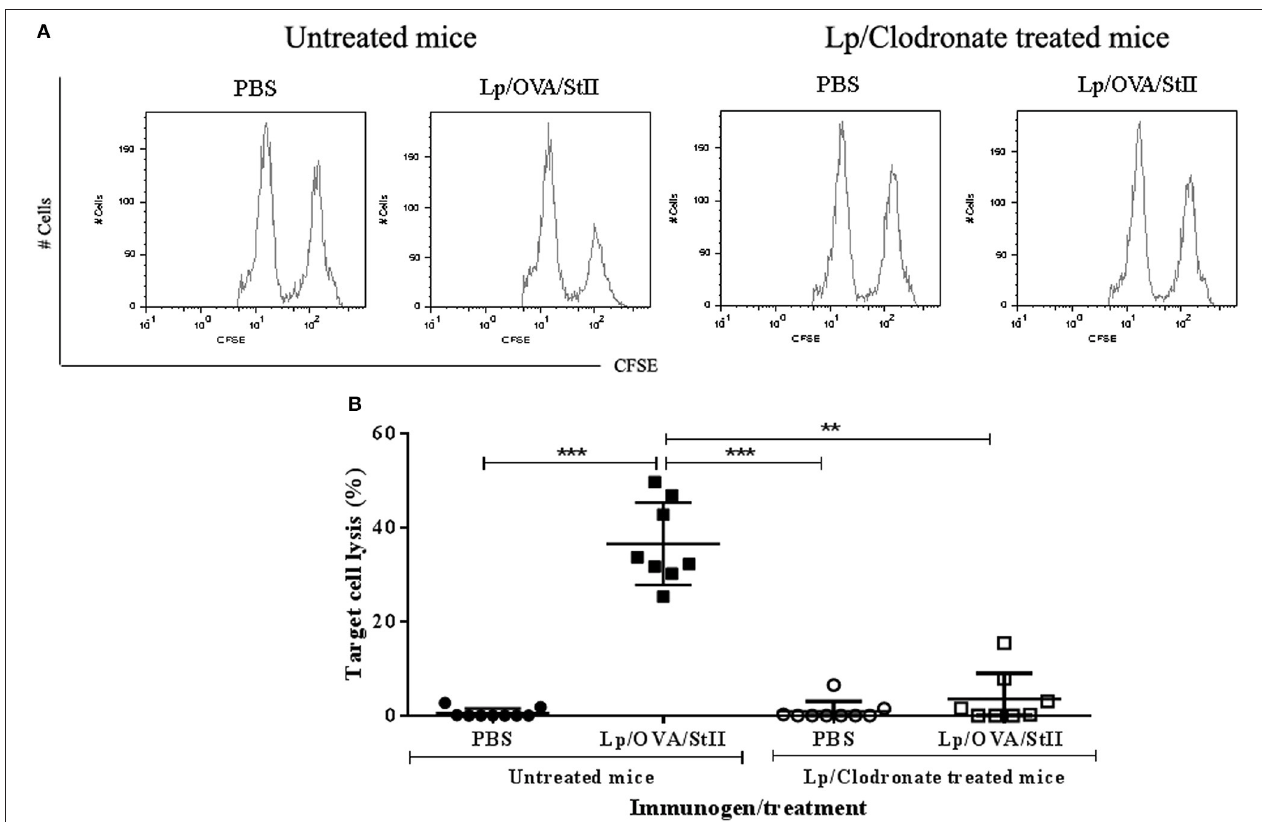
FIGURE 7 | Macrophage depletion abrogates in vivo cytotoxic T lymphocytes response induced by liposomes co-encapsulating OVA with StII. C57BL/6 mice were depleted of macrophages by i.p. injection of liposomes containing clodronate. Mice treated or not with clodronate were immunized s.c. twice at days 0 and 12 with 50 µ g of OVA co-encapsulated with 6.25 µ g StII into DPPC:Chol liposomes (1:1). PBS was administered as control. Seven days after the second immunization, mice received i.v. 6 × 10 7 cells containing an 1:1 proportion of target cells (SIINFEKL-charged and CFSE bright -labeled splenocytes) and control cells (without peptide and CFSE dull -labeled splenocytes). Sixteen hours after injection of the cells, mice were sacrificed and inguinal draining lymph nodes were harvested. Total events corresponding to both fluorescent intensities (CFSE dull and CFSE bright ) were determined by FACS. The percentage of specific lysis was calculated as: 100–[(Total CFSE bright cells/Total CFSE dull cells) immunized mice × 100 × (Total CFSE dull cells/Total CFSE bright cells) PBS ]. (A) Histograms of CFSE dull and CFSE bright cells from an individual mouse representative of each experimental group. (B) Percentages of target cell lysis in individual animals from multiple CTL assays in vivo . Statistical analysis was performed with the Kruskal-Wallis test with Dunn post-test ** p < 0.01, *** p <